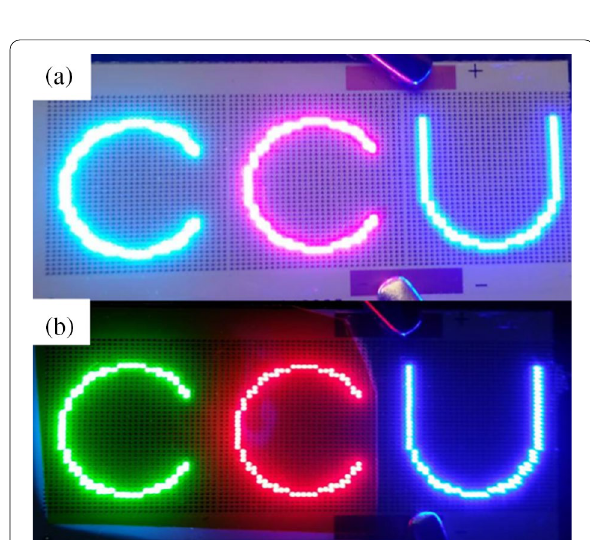
Fig. 15 Micro‑LEDs colors a before and b after addition of RCPEF